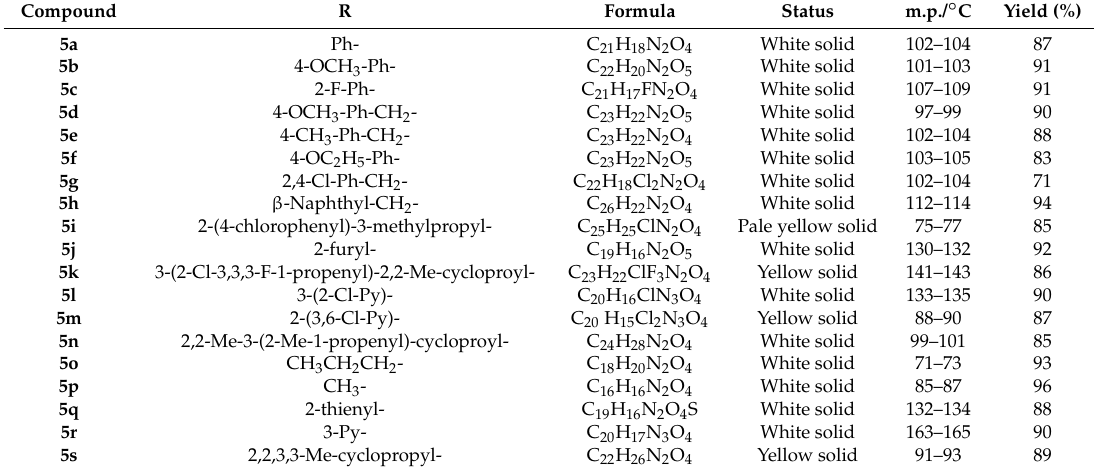
Table 1. Physical data for compounds 5a – 5s .